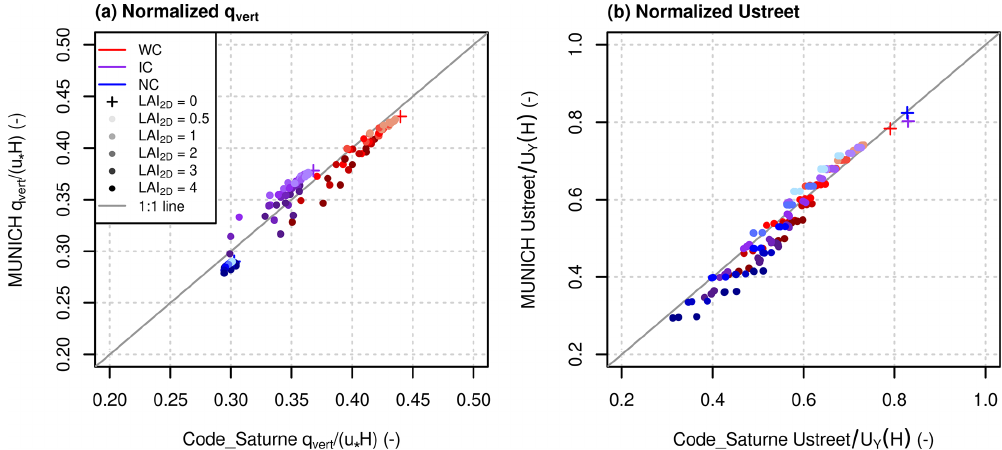
Figure 5. Normalized U street and q vert computed from Code_Saturne simulations for different tree LAI 2D , CVF, and height ratios.